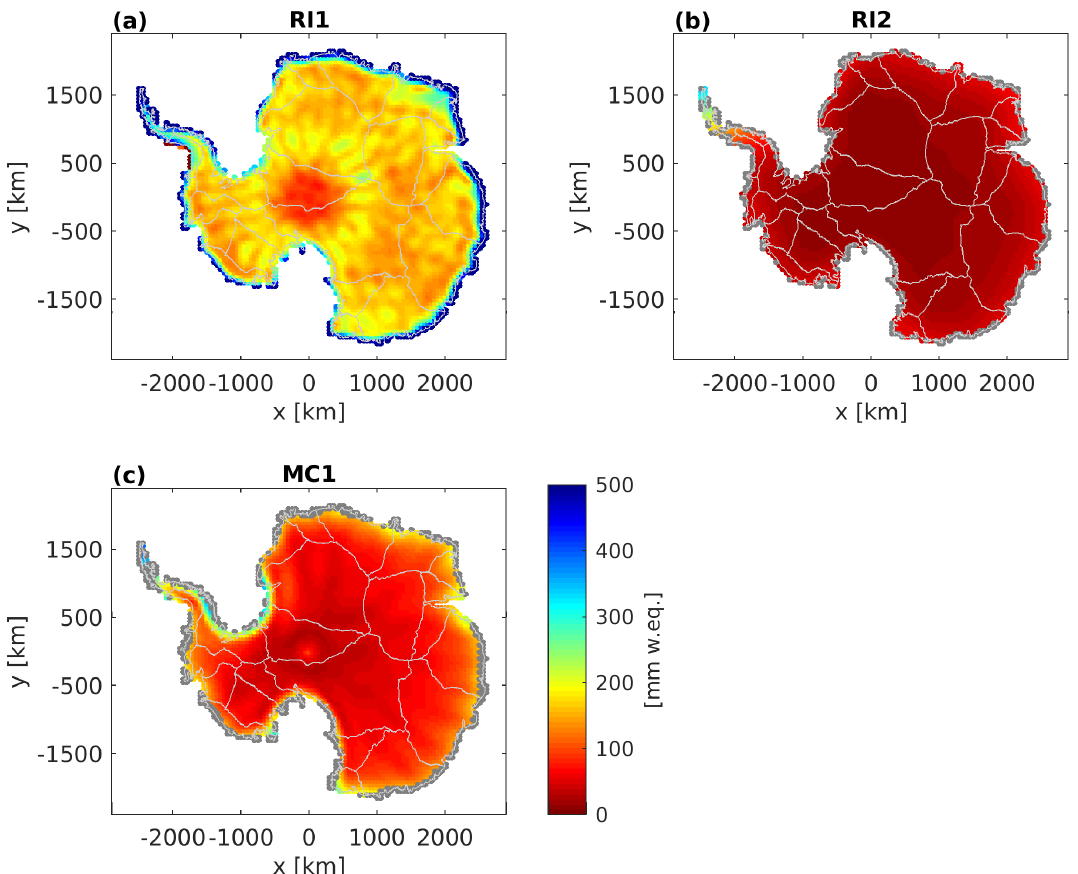
Figure 8. Noise level, given in terms of the scaled standard deviation of the noise time series, estimated from the gridded mass changes. Panels ( a – c ) show results from different groups (Table 3). Grid cells in grey lie outside of the original grid